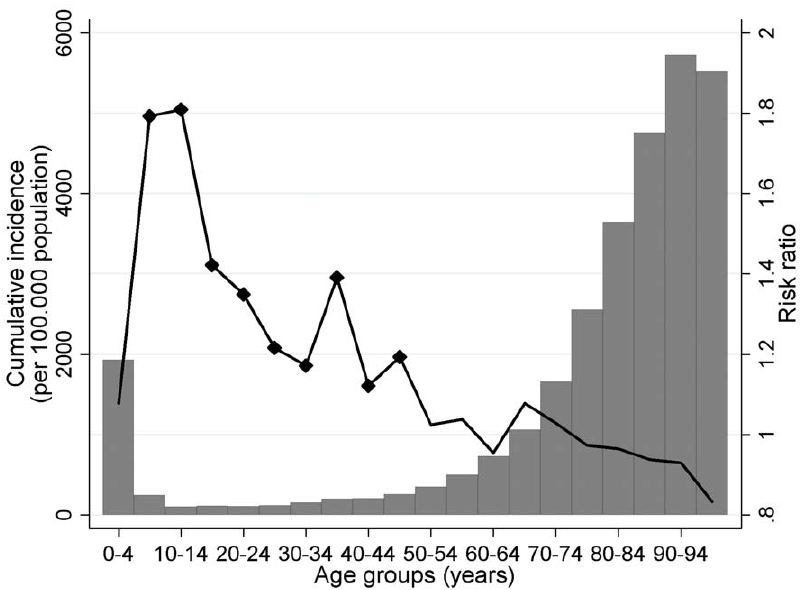
Figure 2. Cumulative incidence and risk ratios of influenza-associated hospitalisations during the 2009 influenza pandemic in Denmark. The cumulative incidence (bars) of influenza-associated hospitalisations for week 30 of 2009 to week 15 of 2010, by 5-year age groups, and the risk ratios (line) for influenza-associated hospitalisations in the pandemic season compared to the five previous seasons adjusted for an optional underlying trend in hospitalisations. In the age range 5 to 49 years, the risk ratios of hospitalisations were significantly higher than in the previous five seasons (estimates marked with diamonds).